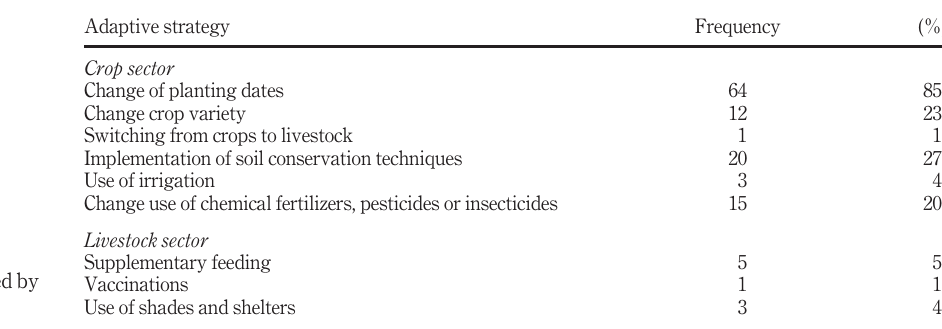
Figure 1. Climate change- related stressors that reduce agricultural productivity as perceived by farmers